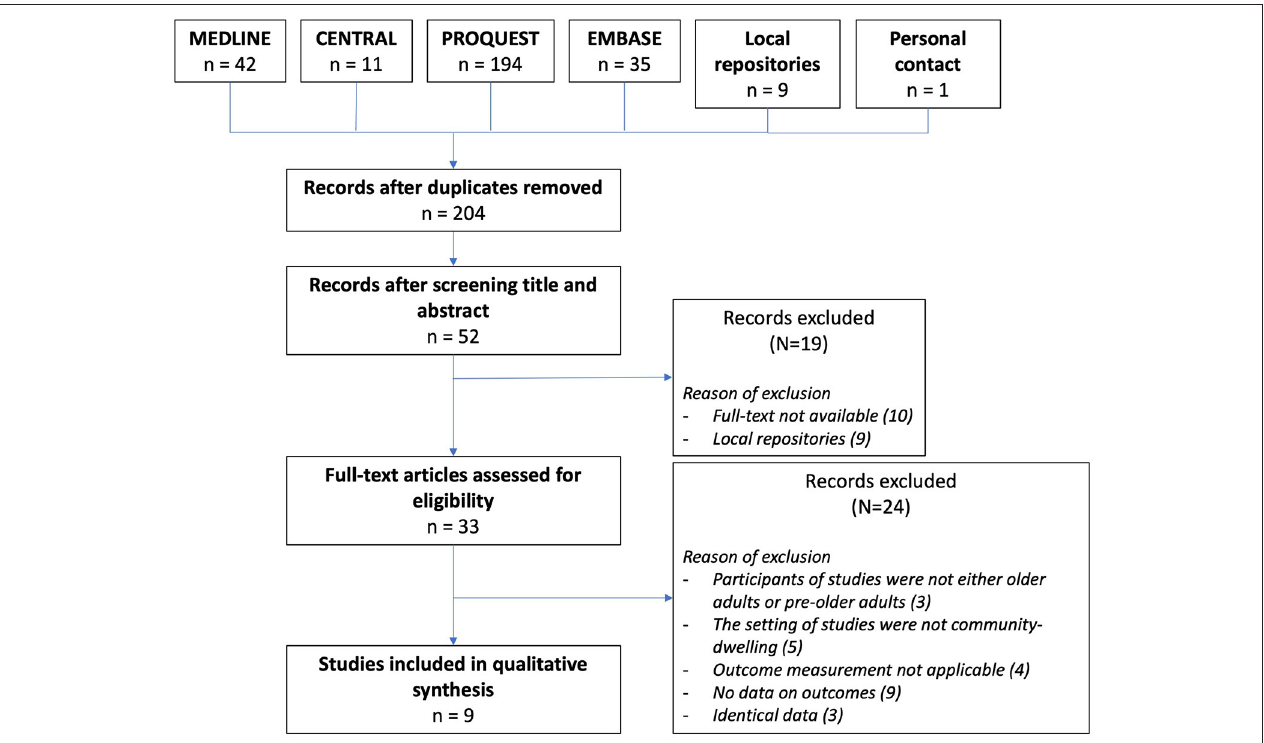
FIGURE 1 | PRISMA flow chart of the searching method resulting in 9 studies included in the systematic